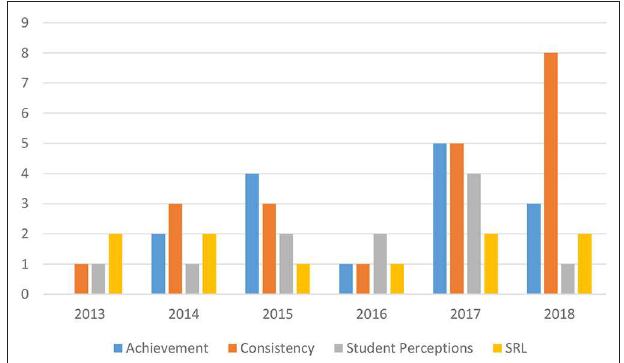
FIGURE 1 | Topics of self-assessment studies,